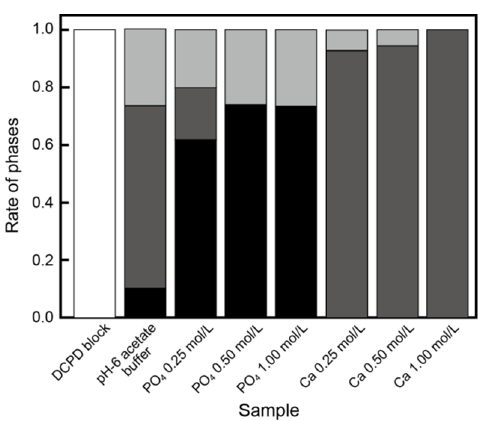
Figure 3. Phase rate of calcium phosphate yields in the samples. White: DCPD. Light grey: DCPA. Dark grey: HAp. Black: OCP. Table 1. Final pH values of a pH-6 acetate buffer solution with PO 4 or Ca at 70 ◦ C for 2 days.